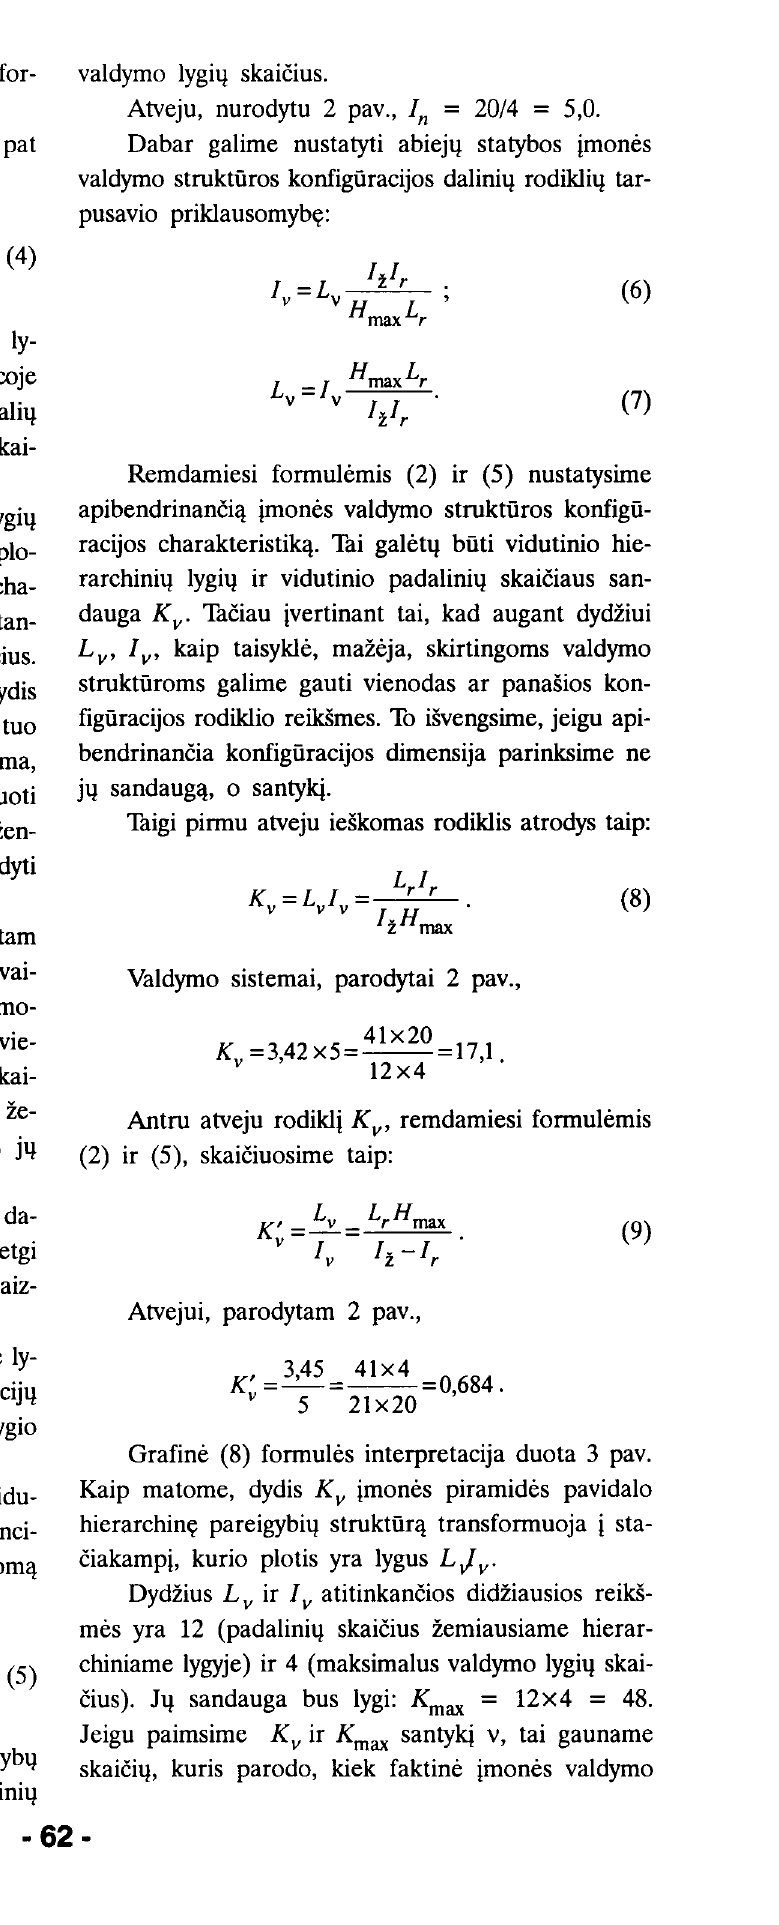
tini visiems hierarchiniams valdymo lygiams instanci